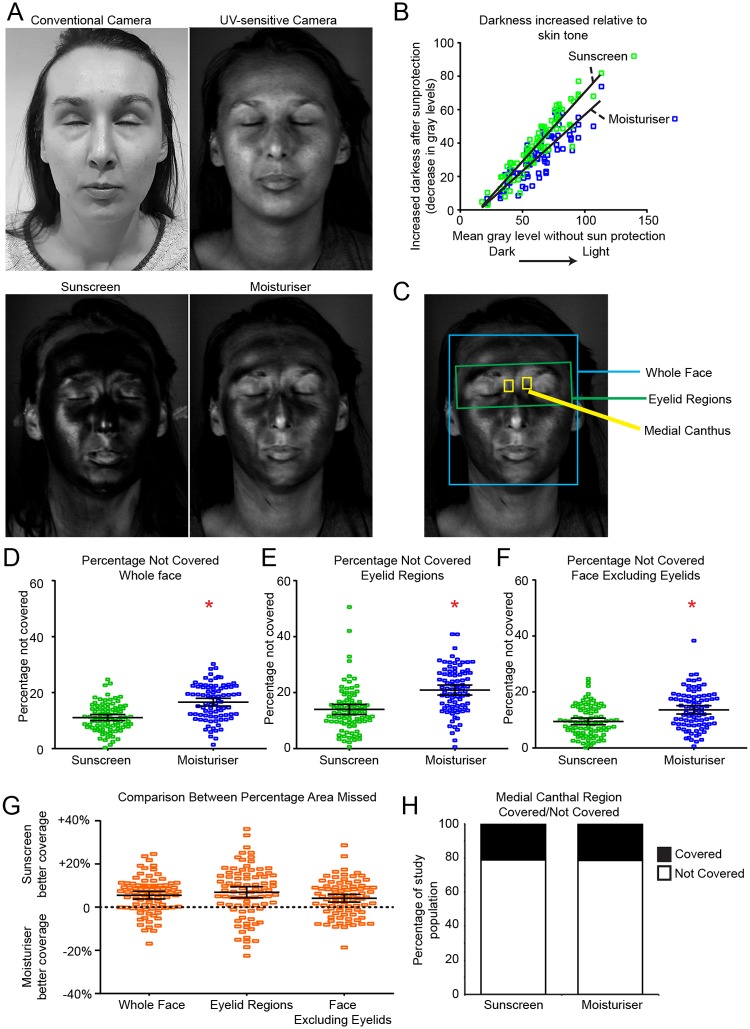
Increased areas of the face and eyelid regions are missed using SPF moisturiser compared with sunscreen.A. Representative images from the same person imaged using a conventional camera (top left), UV-sensitive camera (top right), UV-sensitive camera after application of SPF30 sunscreen (bottom left) and UV-sensitive camera after SPF30 moisturiser application (bottom right). B. Scatter graph of increase in image darkness relative to skin tone. C. Image segmentation for application analysis, boxes represent areas analysed; blue = face, green = eyelid, yellow = medial canthus. D, E and F dot plots of percentage missed with sunscreen and moisturiser in indicated areas. Black lines = mean and SD, n = 84. * indicates significant difference P<0.05 between groups, determined by paired t-test (D) or repeated-measures ANOVA (E and F). G. Within individual difference in area missed between moisturiser and sunscreen, positive scores = more missed after moisturiser application. H. Stacked column graph displaying medial canthus coverage scored as fully covered/missed, plotted as percentage of population.